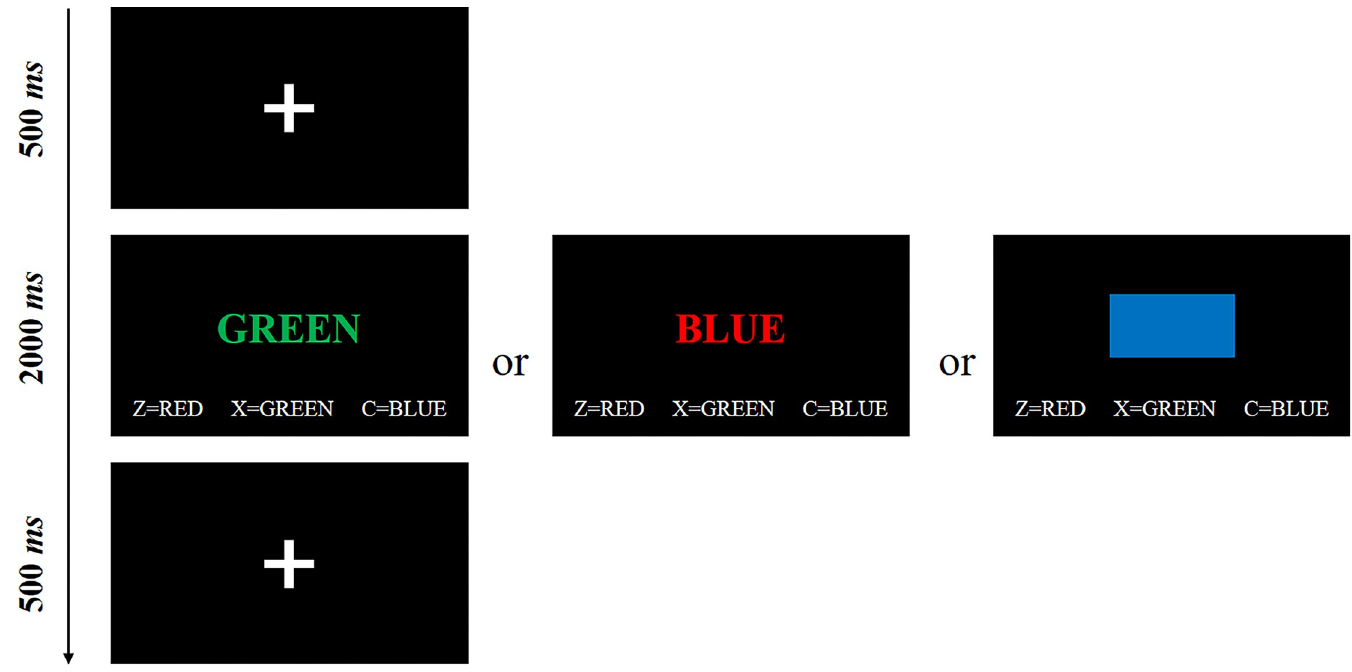
Fig 1. Illustration of Stroop task.